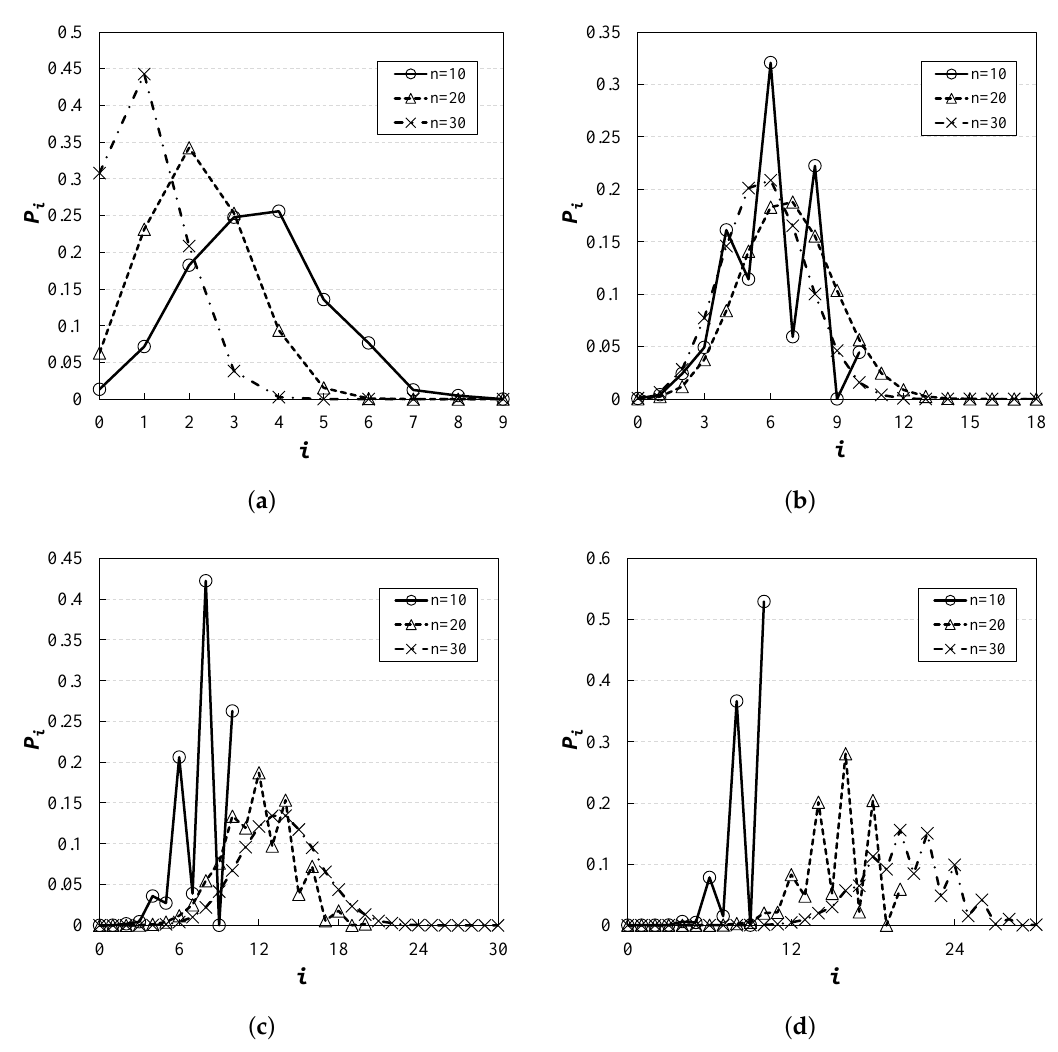
( n , K ) Figure 5. P for different values of n and K , obtained from dynamic programming. When K > n i